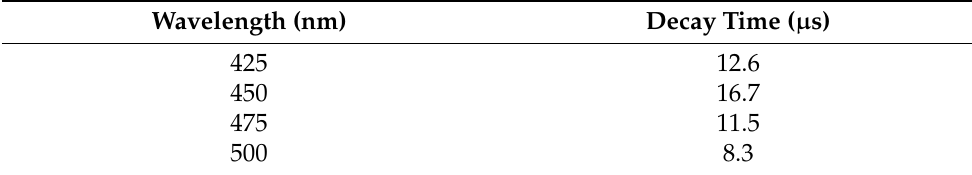
Figure 11. Luminescence decay measured at 450 nm, relative to the electron bunch time. The data were fitted to one exponential decay (orange-dotted line) plus a constant representing the background level (blue-dashed line), as given by Equation (2). Table 2. Decay times of luminescence at different wavelengths in the emission region 425 nm to 500 nm during irradiation with 20 MeV electrons at a normal incidence angle without acrylic